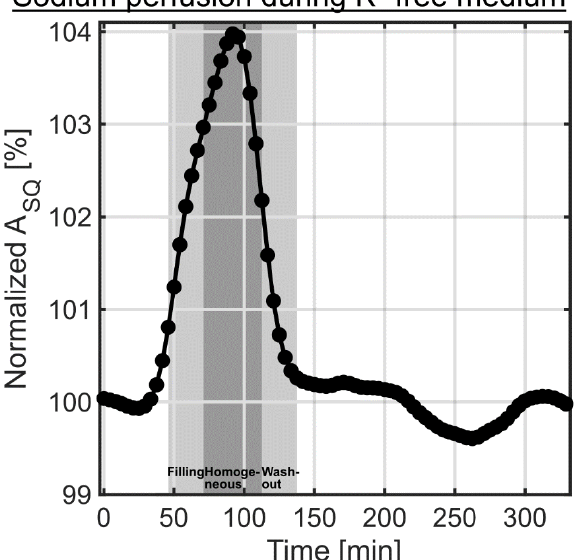
Figure 7. Sodium SQ signal changes during the 0 mM K + medium experiments (n = 6). The two light gray shaded backgrounds indicate the filling and washout of the bolus in the bioreactor, while the dark gray shaded background corresponds to the homogeneous distribution of the bolus in the bioreactor determined using the 1 H MR contrast agent experiment (Figure 2). A slight increase in sodium relaxation times and in the sodium content for 0 mM K + medium compared to normal medium resulted in the observed increase in the sodium SQ signal. The sodium perfusion curve during the 0 mM K + experiments was acquired in the presence of a cell culture on MCAs. It agrees well with the perfusion curve determined using 1 H MR contrast agent (Figure 2).